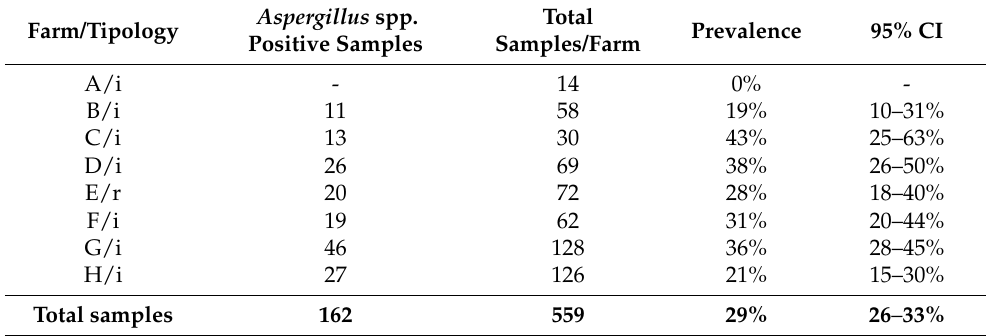
Figure 3. Mycological examination of the colonies referable to black aspergilli grown onto CZA. ( a ) Macroscopic surface of the colonies; ( b ) Macroscopic reverse of the colonies; ( c ) Microscopic features of the colonies (methylene blue staining, ×20, bar 50 µm). In Table 3 the distribution of positive samples for Aspergillus spp. in the investigated farms is showed. Table 3. Aspergillus spp. prevalence distribution by farm. Legend: i = intensive; r = rural.